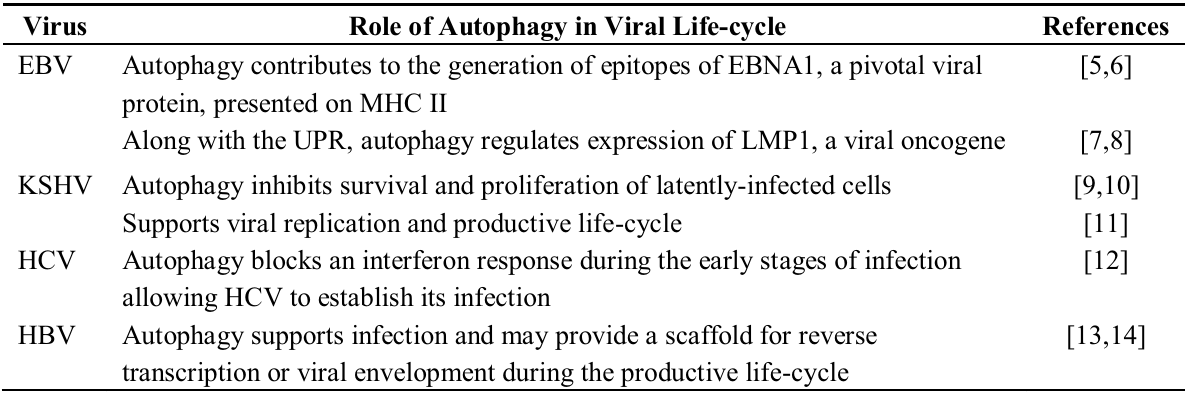
Table 2. Multiple roles for autophagy in the life-cycles of human tumor viruses. Virus Role of Autophagy in Viral